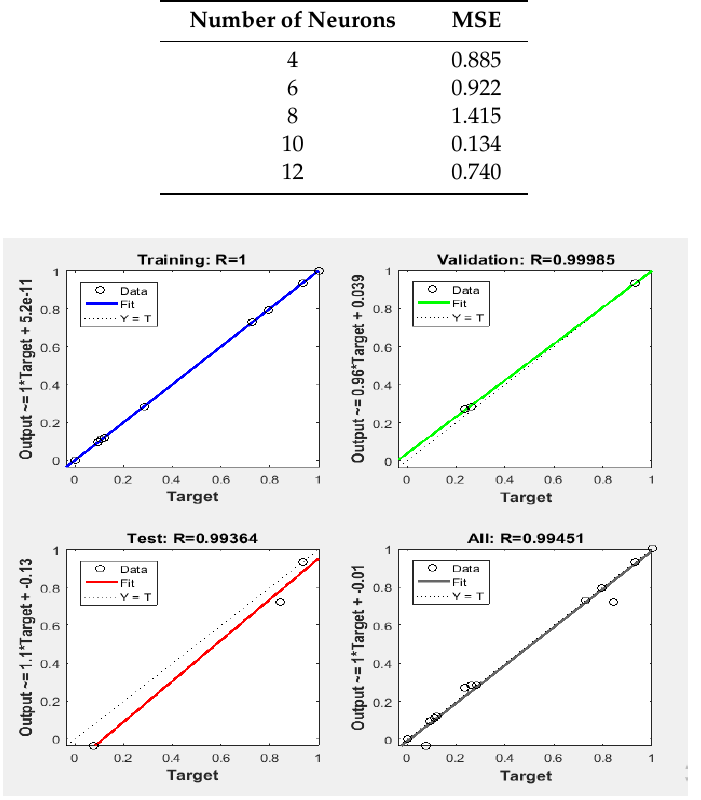
Table 4. Effect of the number of hidden layer neurons on the performance of the neural network.